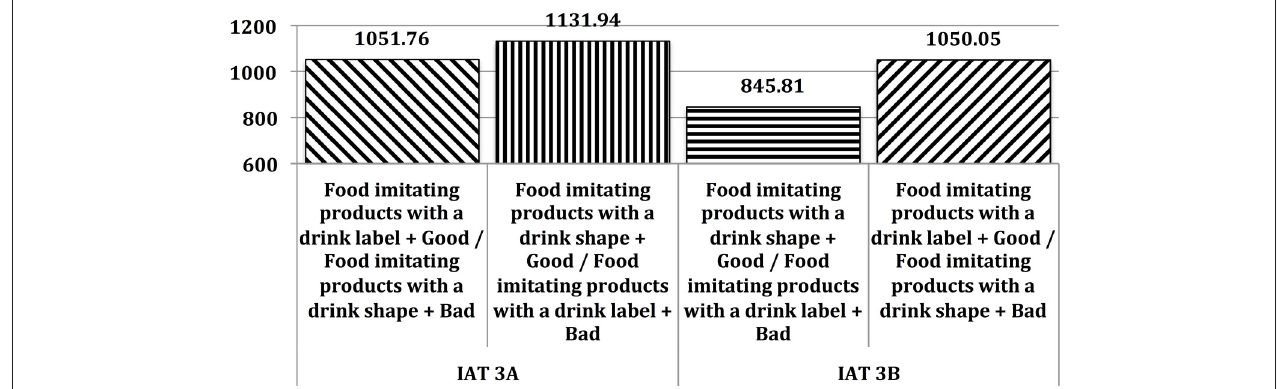
FIGURE 4 | Mean response latencies (in milliseconds) in Study